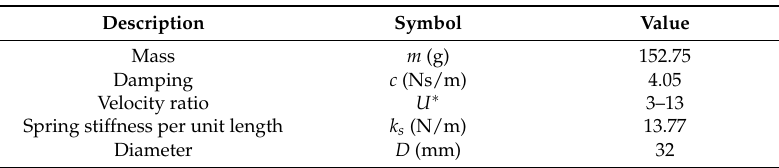
Table 2. Physical model parameters for the simulation.